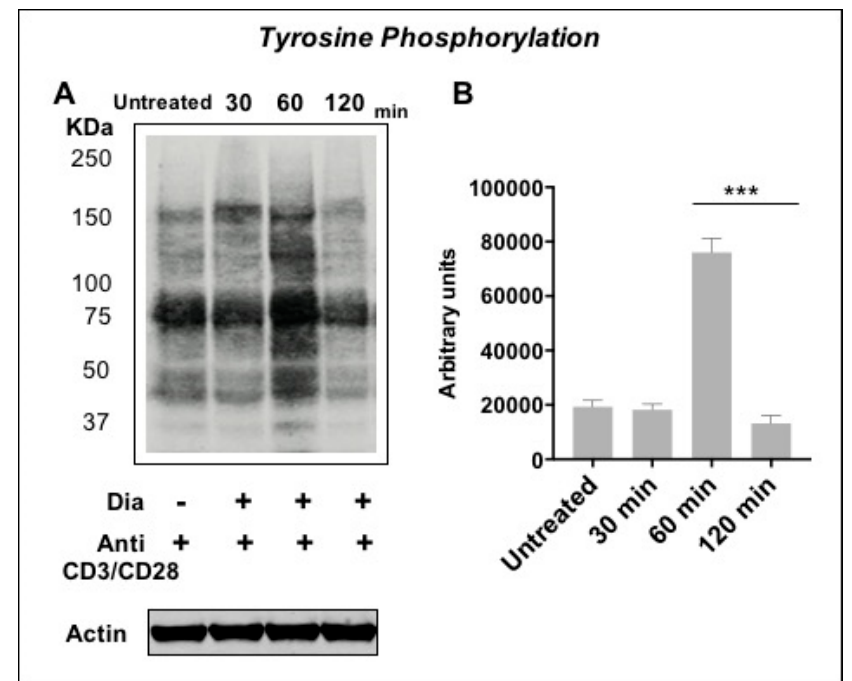
Figure 3. T cells tyrosine phosphorylation under oxidative condition. ( A ) Western blots of anti-phosphotyrosine T cells total proteins treated with 0.3 mM diamide. Beta-actin loading control is showed. ( B ) Quantification of tyrosine phosphorylation levels was performed by IR fluorescence detection (Odyssey, Licor, USA). *** ( p < 0.001) indicate the incubation time that determines a statistically significant change between samples measured by student T -test (N = 3).